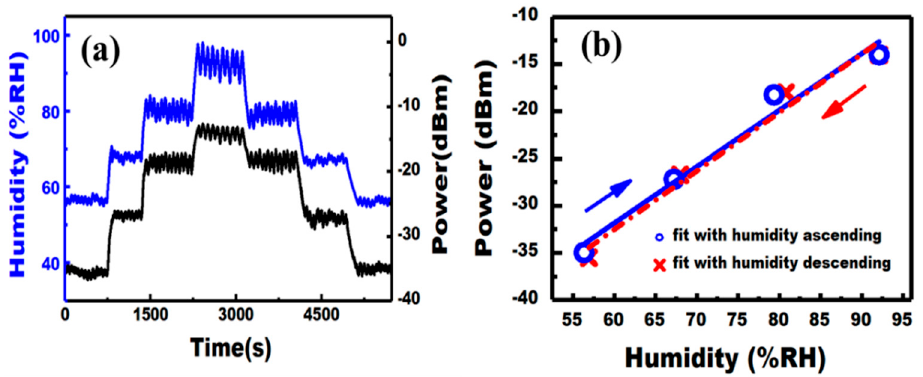
Figure 6. ( a ) Variation of the optical transmitted power with the chamber RH. ( b ) Relationship between the transmitted power and RH of SnS 2 -based device.